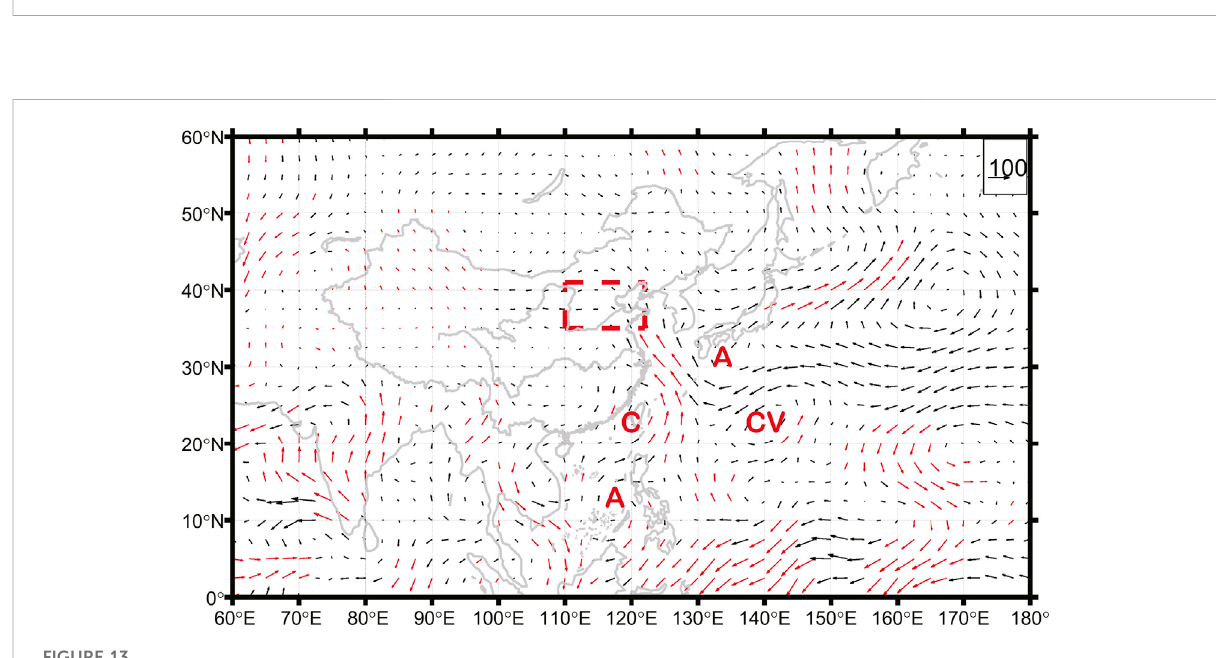
FIGURE 13 The same as Figure 10, but for the vertically integrated water vapor fl ux (unit: